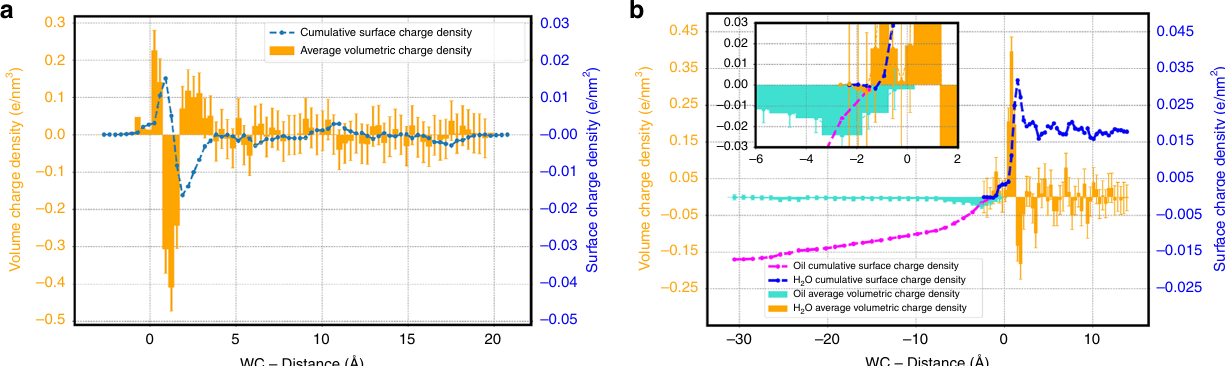
Fig. 2 Volumetric and surface density pro fi les. Volumetric charge density (orange bars) and integrated surface charge density (blue line) obtained for the DDEC charges extracted from our calculations for the air – water ( a ) and oil – water ( b ) interfaces. Different axis scales were used to fi t both pro fi les in the same graph. The left axis refers to the volumetric charge density, whereas the right one refers to the integrated surface charge density. For the oil phase in the right panel, the charge density is reported using turquoise bars and the integrated surface charge density is shown by the magenta line. The inset in the right panel magni fi es the charge oscillations right at the interface between the two phases. The error bars reprsent the standard deviations calculated from the single frames charge densities with respect to the average